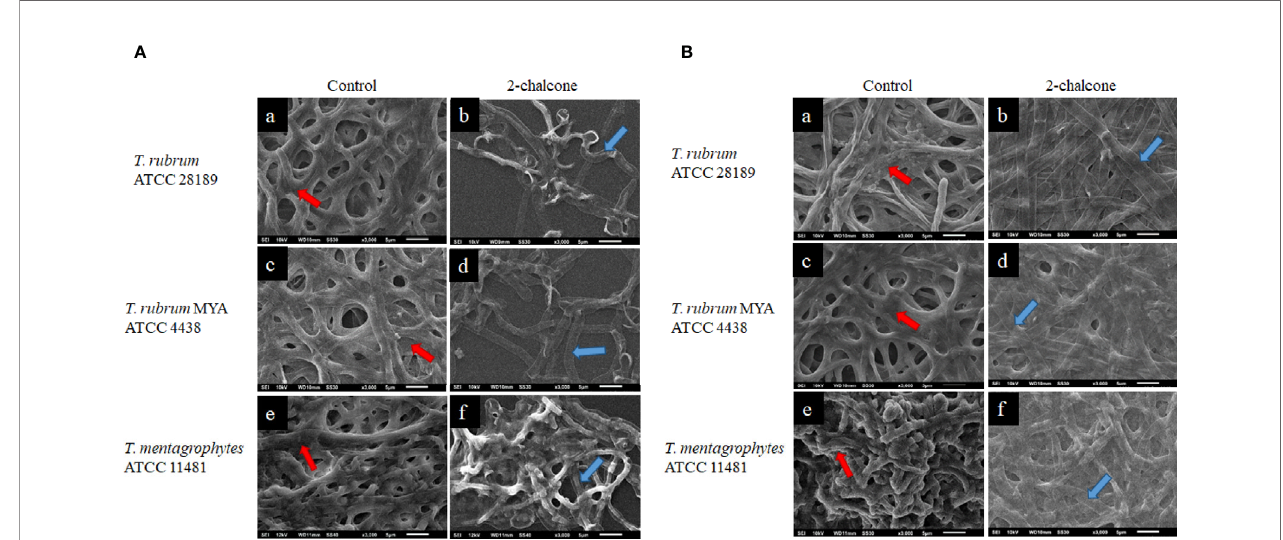
FIGURE 5 | Scanning electron microscopy (SEM) images of early stage (A) and mature bio fi lms (B) of T. rubrum ATCC 28189, T. rubrum ATCC MYA-4438, and T. mentagrophytes ATCC 11481 untreated (a, c, e) and treated with 2-chalcone in the dark (b, d, f). The images of untreated bio fi lms show a robust bio fi lm, formed with the entanglement of integral hyphae and covered with a polymeric extracellular matrix (red arrows). Bio fi lms treated in the early-stage with 2-chalcone present a low density showing the action of 2-chalcone in inhibiting their maturation. In mature bio fi lms, as in the early-stage bio fi lms, 2-chalcone promoted total hyphal collapse (blue arrows).